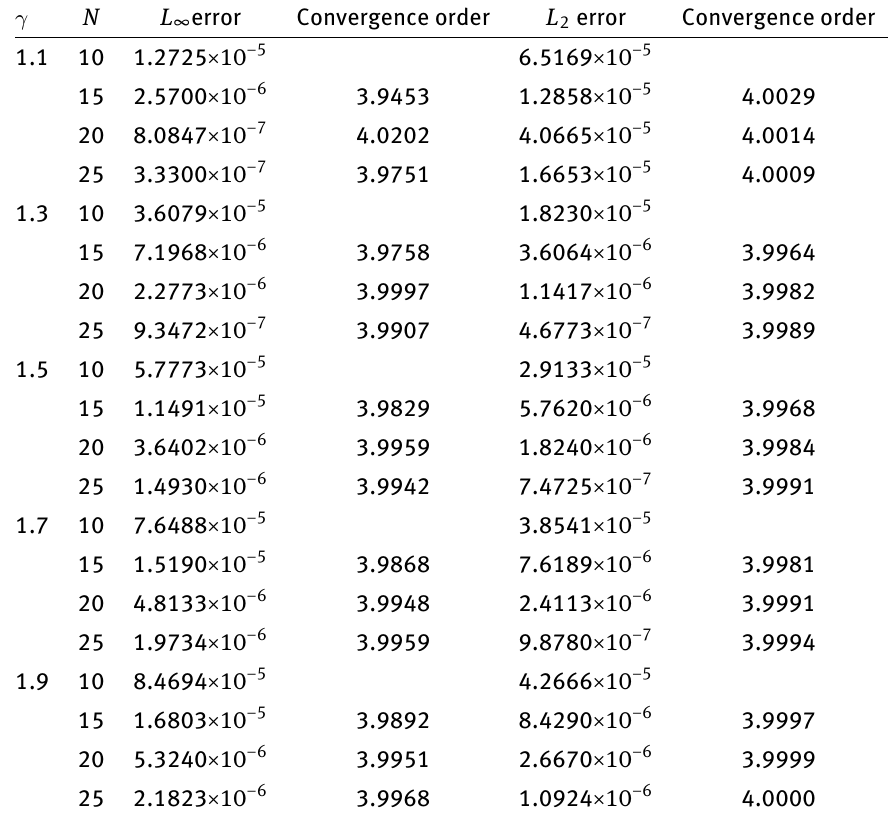
Table 8: The L ∞ , L 2 errors and spatial convergence orders for Example